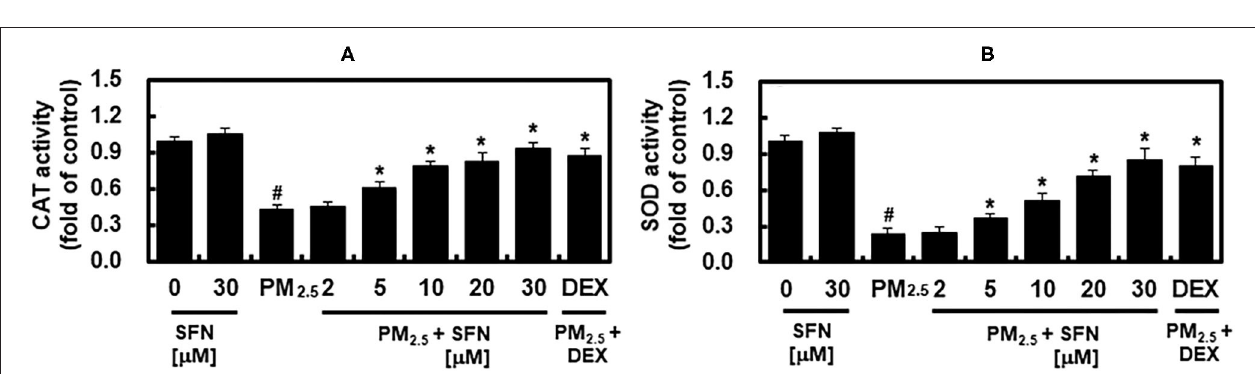
FIGURE 4 | Effects of Sulforaphane (SFN) on PM 2.5 -induced ROS generation. (A) ARPE-19 cells were treated for the indicated times with the following concentrations of PM 2.5 : 25 µ g/mL (closed circle), 50 µ g/mL (closed square), or 100 µ g/mL (closed triangle). Intracellular ROS levels were determined using DCFH-DA. DCFH-DA fluorescence values are expressed as the fluorescence ratio (fold) between PM 2.5 -treated cells and untreated control cells. (B) ARPE-19 cells were treated with the indicated concentrations of SFN or DEX (1 µ M) 24h after being challenged with PM 2.5 (100 µ g/mL). After treatment, ROS levels were measured. Values represent the mean ± SD of three independent experiments. * p < 0.01 relative to 0h group (A) or PM-challenged group (B) , one-way ANOVA. # p < 0.01 relative to control (B) , one-way ANOVA.